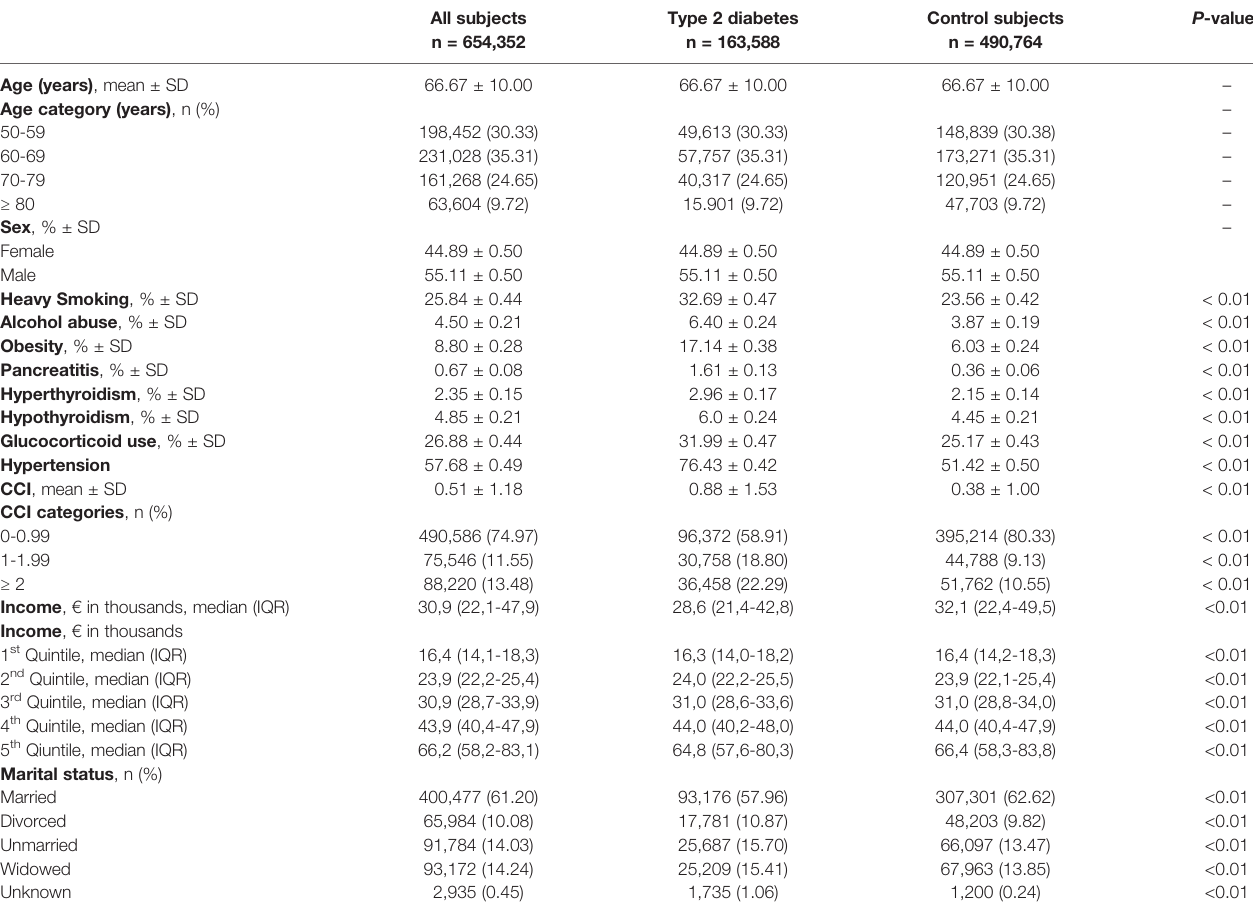
TABLE 1 | Characteristics of case subjects (type 2 diabetes) and control